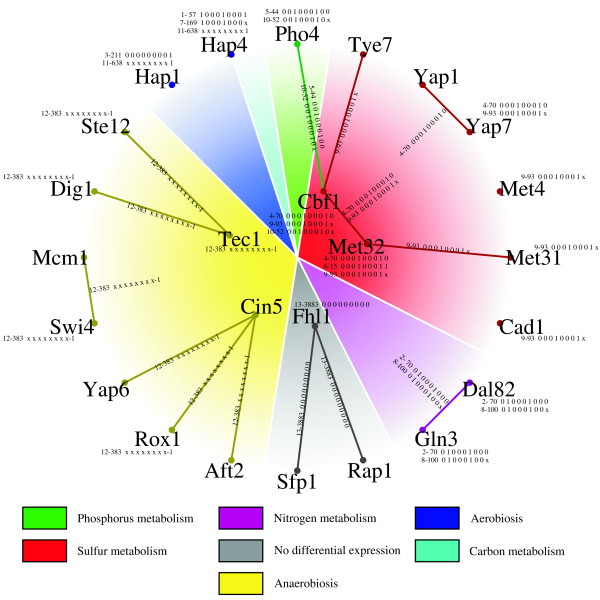
TF Circle. The TF circle depicts all the TFs and TF pairs, which are significantly related to at least one module. Related modules are represented by strings in the vicinity of the relevant TF or, in the case of a TF pair, in the vicinity of the line connecting both TFs. The strings are made up out of three parts. The first number represents the number that was assigned to the module. The second number indicates the number of genes in the module. The third part is the discretized expression pattern of the genes in the module. Here, an 'x' indicates the irrelevance (don't care) of a particular cultivation parameter. The color coding of the circle is based on the discretized expression representation of the modules. The placement of the TFs (near the center or the edge) is for reasons of visibility only.